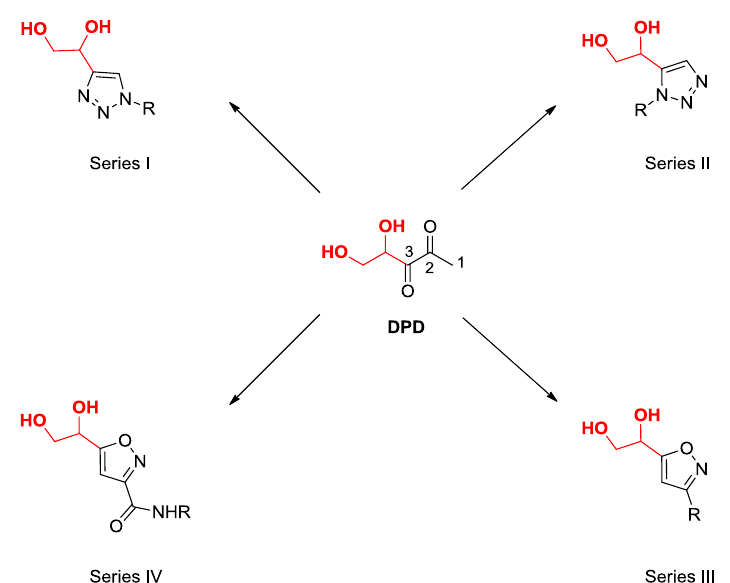
Figure 2. The DPD-related compounds presented in this work.